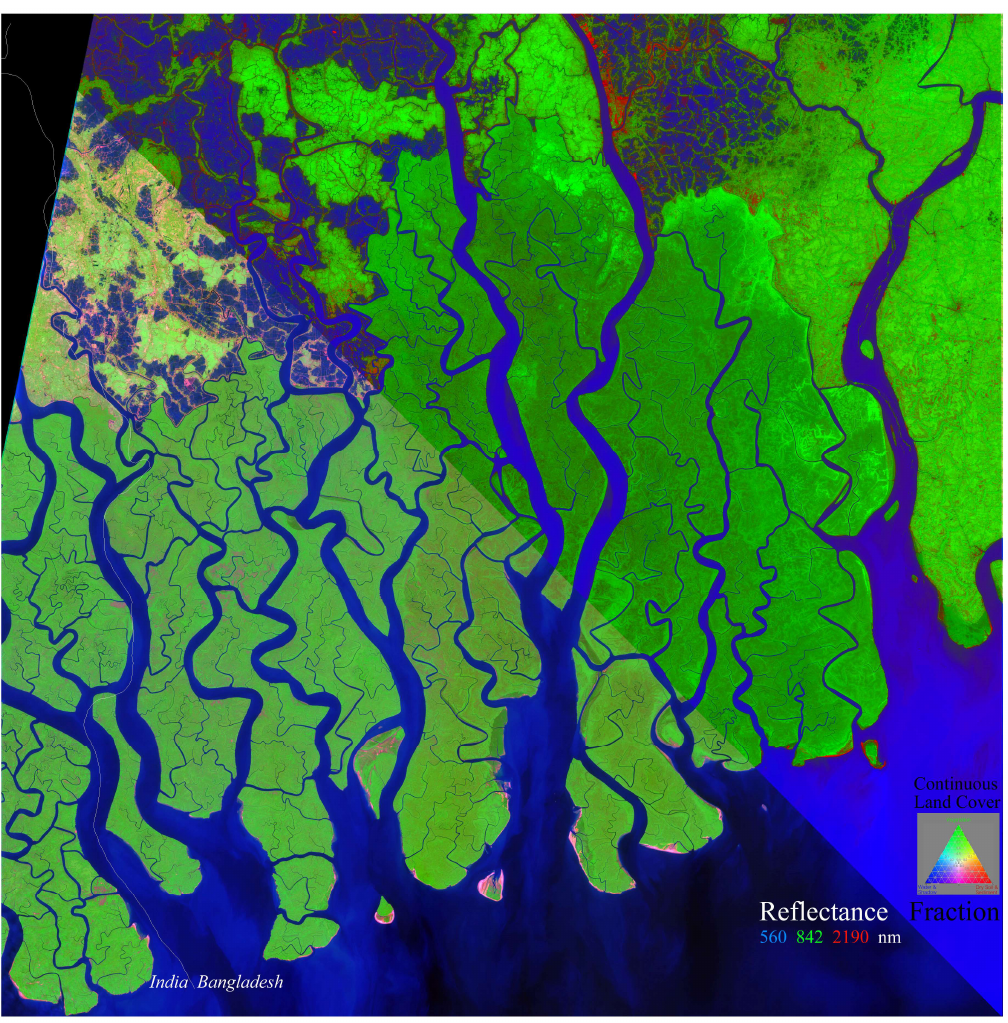
Figure 3. Reflectance \ Fraction composites of post-monsoon Sentinel 2 HLS for jd 322 of 2018. Spectral unmixing of the HLS reflectance by inversion of a 3 endmember linear spectral mixture model using standardized spectral endmembers projects the 11 reflectance bands onto a ternary land cover space to yield per-pixel fractional abundance estimates of sediment and soil Substrate, illluminated Vegetation and Dark fractions of water or shadow. The diagonal split illlustrates the e ff ectiveness of the ternary mixture model by greater separation of primary colors as physically distinct land cover